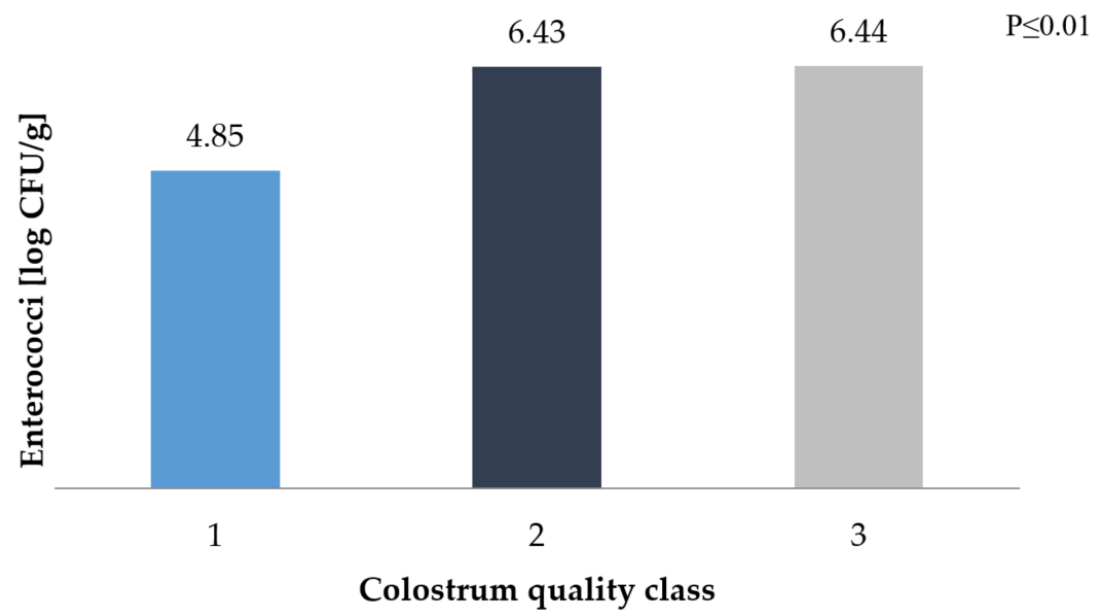
Figure 5. Enterococci count in faecal samples depending on the class of colostrum.